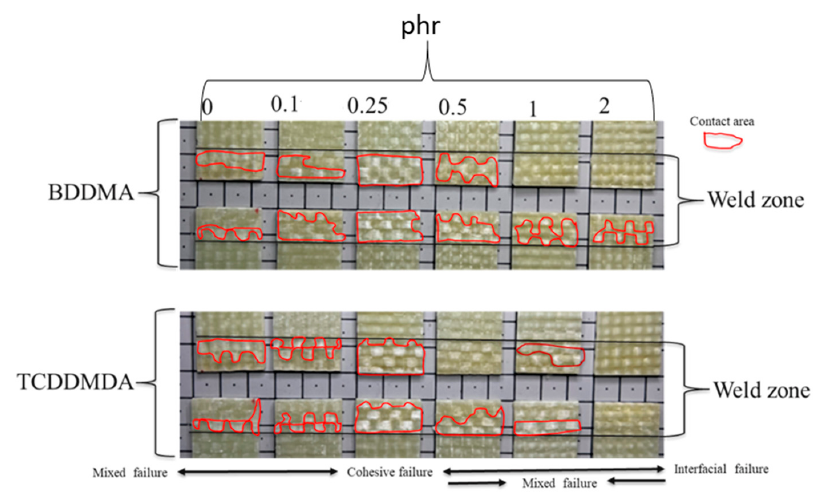
Figure 8. Macroscopic failure images of Elium ® composites with varying phr values of multifunc- tional methacrylate monomers.